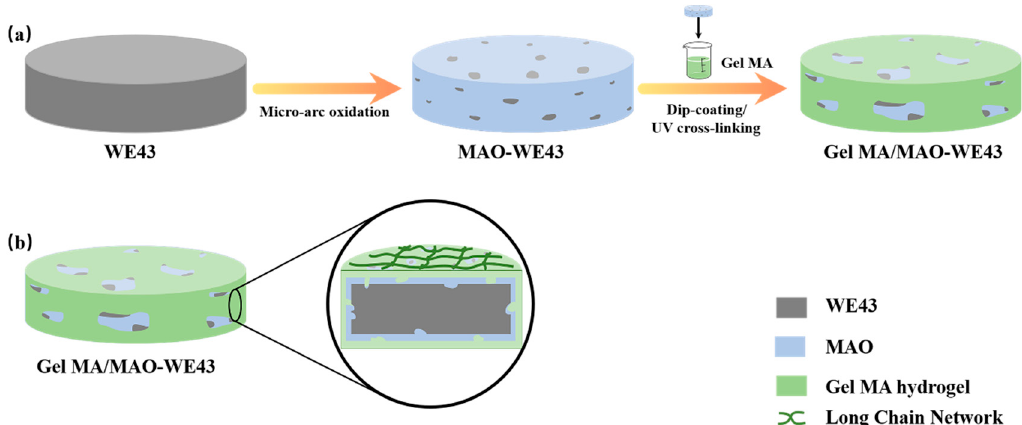
Figure 1. Schematic diagram illustrating the preparation process of the GelMA / MAO (micro-arc oxidation) composite coating on the WE43 magnesium alloy substrate: ( a ) WE43 magnesium alloy substrate pretreated by polishing, cleaning, and drying; the MAO coating prepared on the magnesium alloy substrate; the GelMA hydrogel coating prepared on the MAO-WE43 alloy with the dip-coating method; the GelMA / MAO-WE43 alloy pretreated by UV irradiation; ( b ) Section diagram of the GelMA / MAO-WE43 alloy.